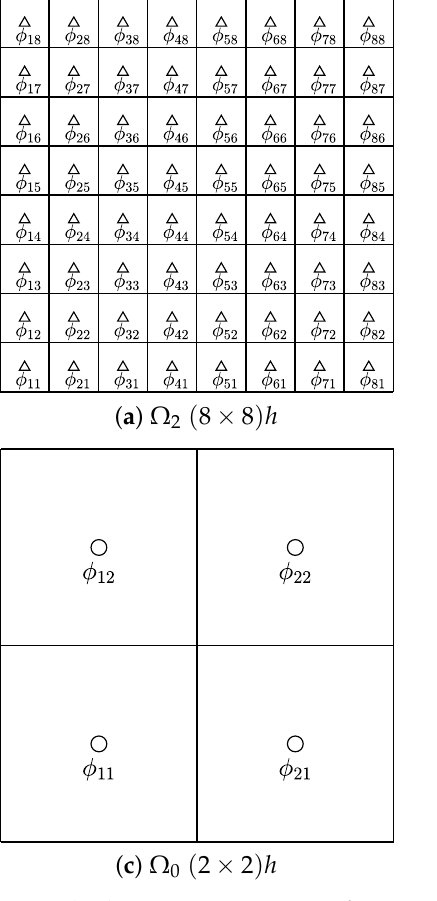
Figure 2. ( a – c ) represent a sequence of coarse grids starting with h = L / N x . ( d ) depicts a composition of grids, Ω 2 , Ω 1 and Ω 0